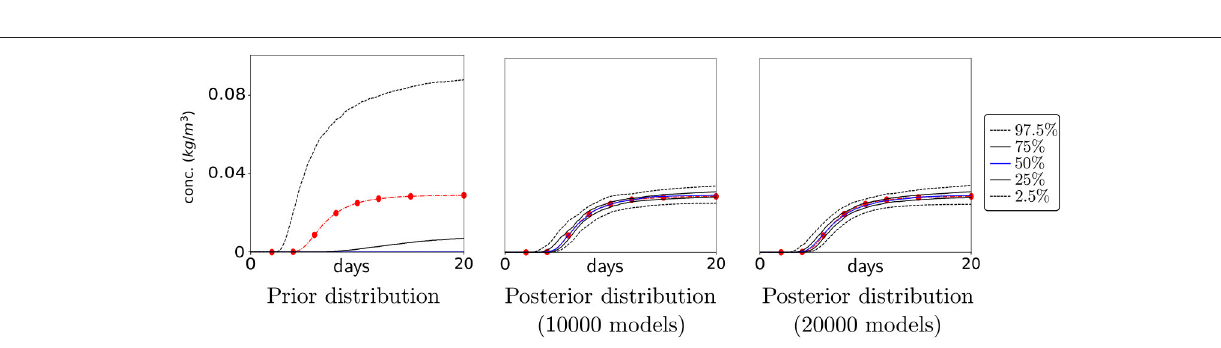
97.5% (dashed), 25 − 75% (full) and average (blue) curves